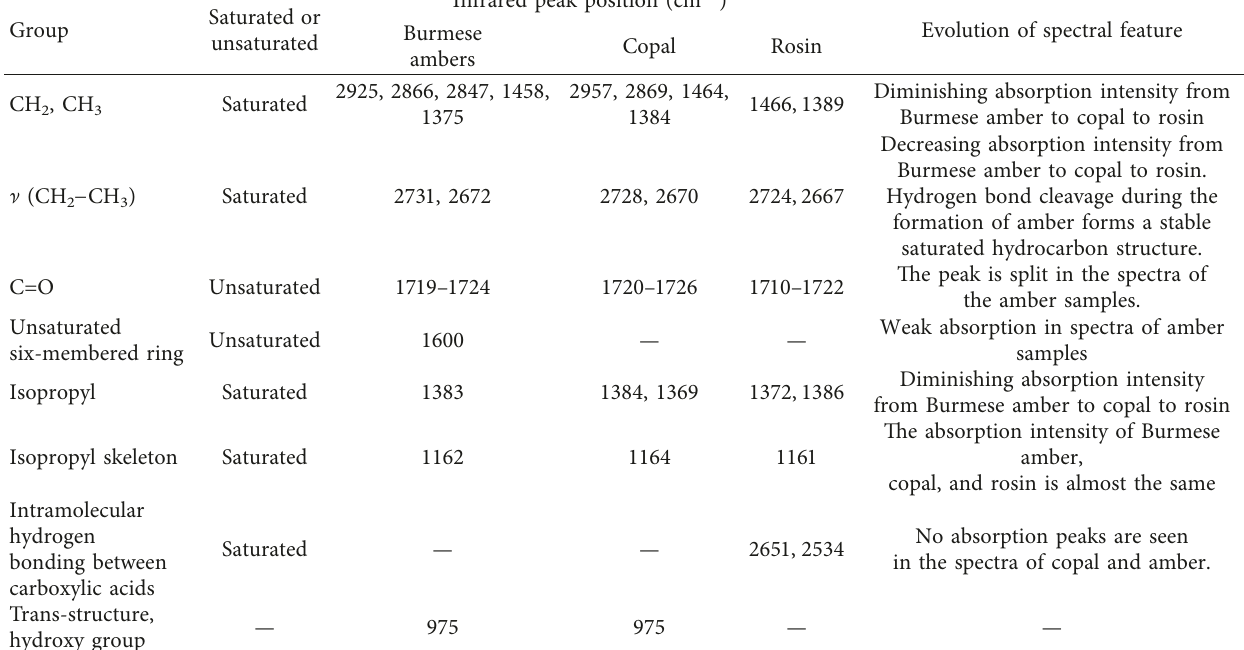
Table 1: Infrared peak attributions of the